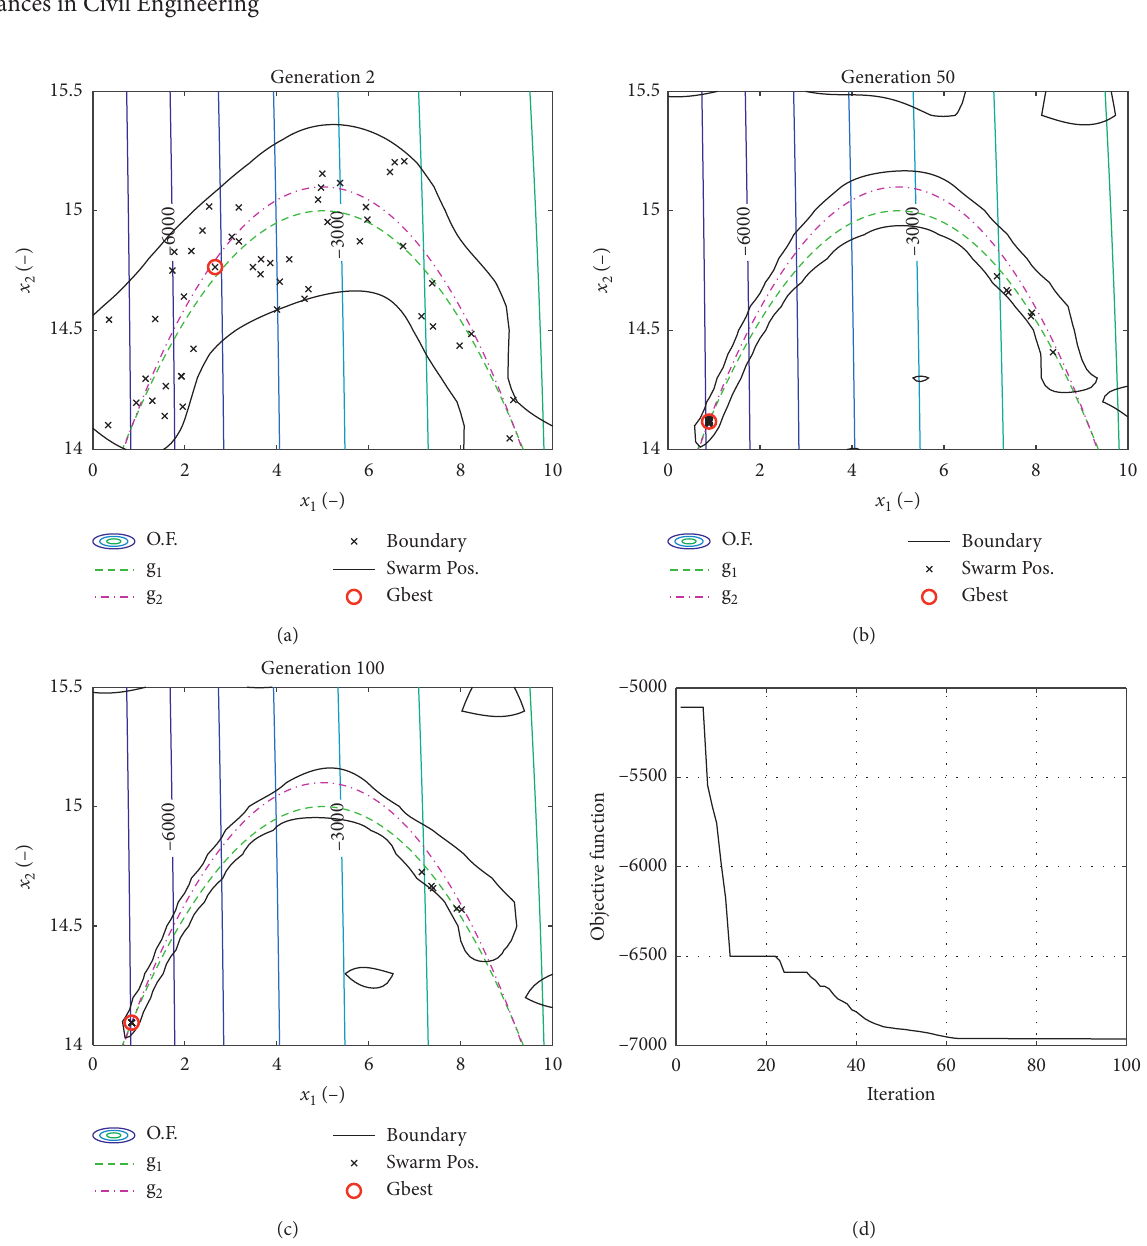
Figure 3: Example 1 (sickle problem [45]): case constant relax constraints’ function. (a) Generation 2. (b) Generation 50. (c) Generation 100. (d) Objective function history. Table 1: Numerical Example 1 (sickle problem [45]): comparison of PSO-SVM, GA, and PSO-penalty.